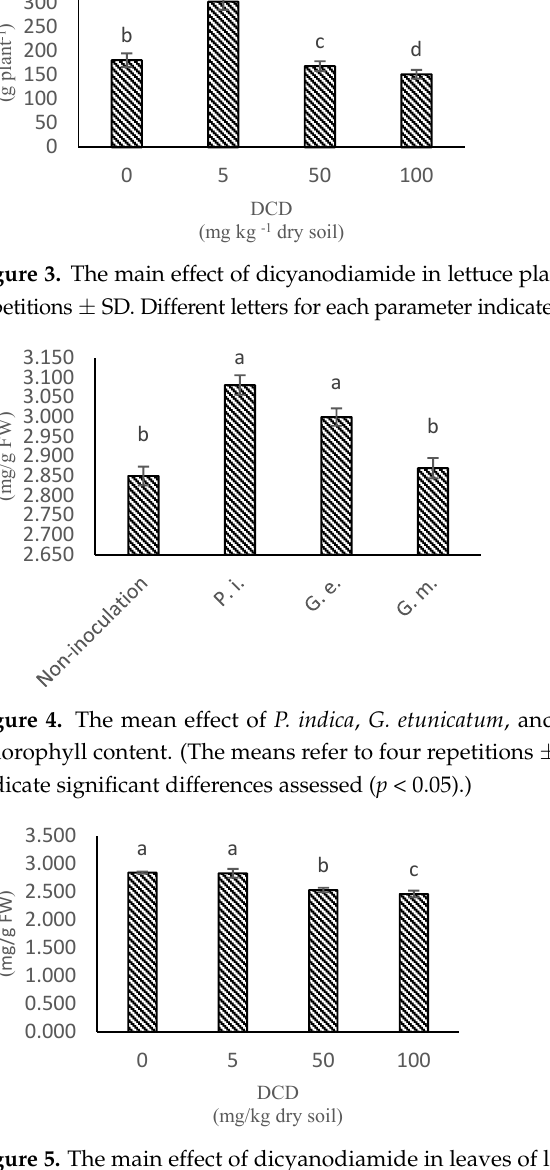
Figure 6. The main effect of dicyanodiamide in leaves of lettuce on carotenoid content. (The means refer to four repetitions ± SD. Different letters for each parameter indicate significant differences assessed ( p < 0.05).) 3.4. Dicyandiamide in the Leaves Leaf analyses showed that DCD can accumulate in lettuce leaves, especially when present at high concentrations in _1 the root medium, and those symbiotic fungi may de- crease this accumulation (Figure 7). P. indica was more efficient in restraining leaf DCD concentrations than G. etunicatum or G. mosseae , showing that at least some fungi may be relevant to reduce the phytotoxicity of nitrification inhibitors. However, the mechanism through which the fungi act is not clear yet [43]. Fungi may help the plant to overcome the stress caused by high DCD concentrations, but they may also accelerate DCD degra- dation in the soil or inside the plant [2,44,45]. Two independent experiments performed by Binet et al. [46] and Aranda et al. [47] showed that mycorrhiza significantly reduced the concentration of anthracene in plants by 20–40% compared to the control. The work by Zhou et al. [48] highlighted the capacity of mycorrhizal fungi to protect Medicago sativa plants against the toxic effects of polycyclic aromatic hydrocarbon. It is possible that pol- lutant compounds such as DCD adsorb to the fungal cell walls, which would decrease the free concentration of the compounds to be absorbed by the plant [43]. Figure 8A–M show